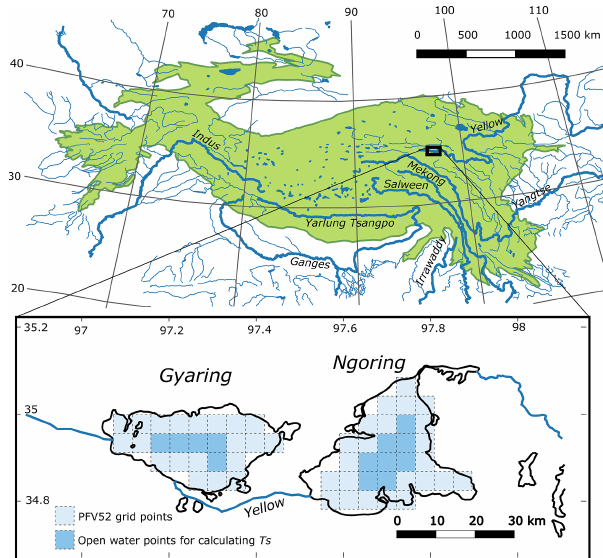
Figure 1. The study site map and the points of the AVHRR Pathfiner grid used for estimation of the surface temperature from satellite data. The green shaded region is the Tibetan Plateau, shown as land above